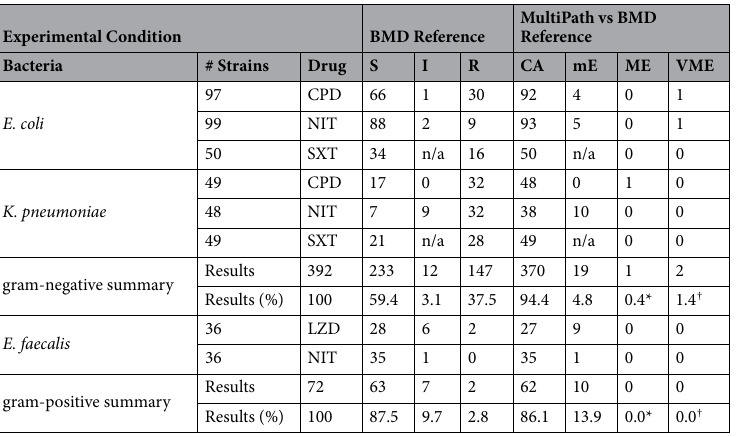
Table 4. MultiPath AST accuracy compared to the BMD reference method. MultiPath samples were contrived in PBS with various strains as indicated at 1 × 10 5 CFU/mL ( E. coli, K. pneumoniae ) or 1 × 10 6 CFU/mL ( E. faecalis ). MultiPath results were generated in microwell AST assays using 4 h of growth and analyzed using relative growth in the presence and absence of antibiotic. S, I and R are susceptible, intermediate, and resistant, respectively. CA, mE, ME and VME are abbreviations for categorical agreement, minor error, major error (false resistance) and very major error (false susceptibility), respectively. *ME percentage is calculated relative to BMD susceptible results. †VME percentage is calculated relative to BMD resistant results. n/a is not applicable; CPD = cefpodoxime; NIT = nitrofurantoin; SXT = trimethoprim-sulfamethoxazole; LZD =